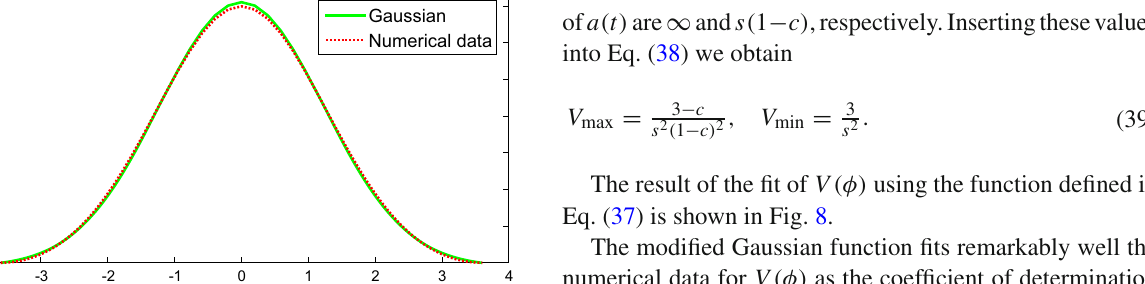
of a ( t ) are ∞ and s ( 1 − c ) , respectively. Inserting these